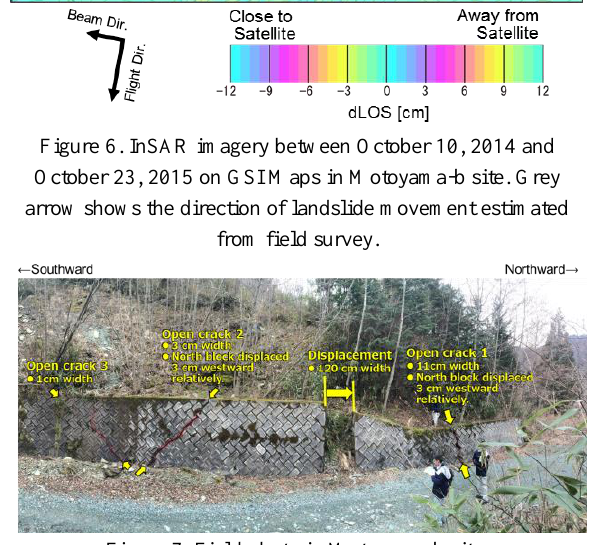
Figure 7. Field photo in Motoyama-b site. Concrete block wall beside a forest road had some open